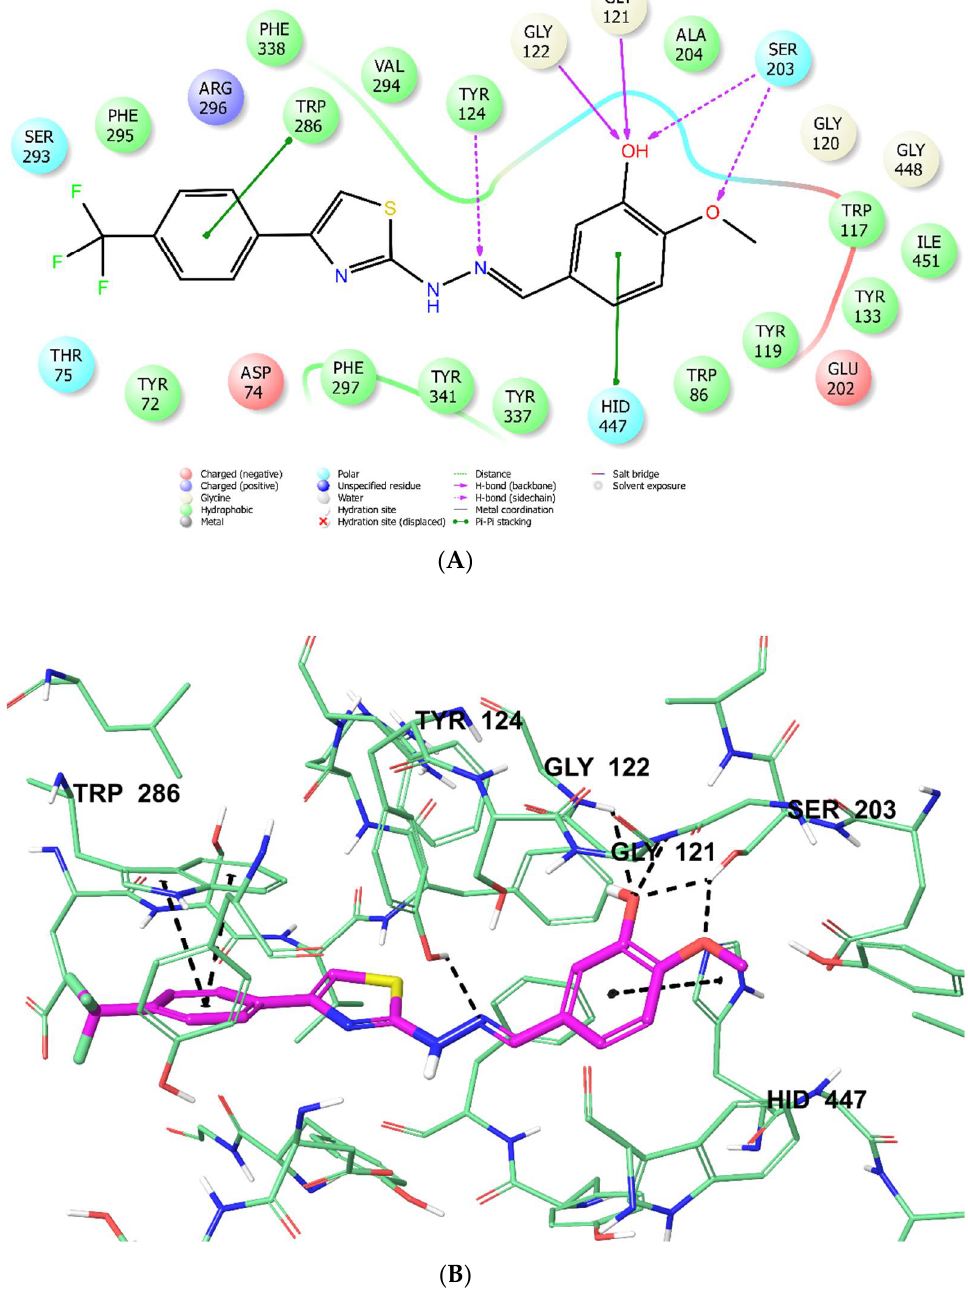
Figure 4. The two- ( A ) and three-dimensional ( B ) interacting mode of compound 2i in the active region of AChE. The inhibitor and important residues in the active site of enzyme are presented by a tube model colored with purple and aquamarine, respectively (AChE PDB Code: